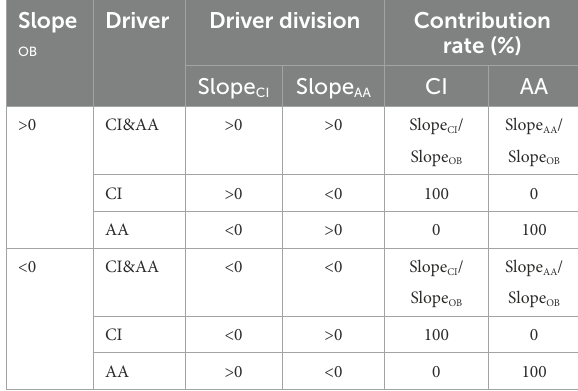
TABLE 2 Determination of dominant factors of anthropogenic activities and natural factors on